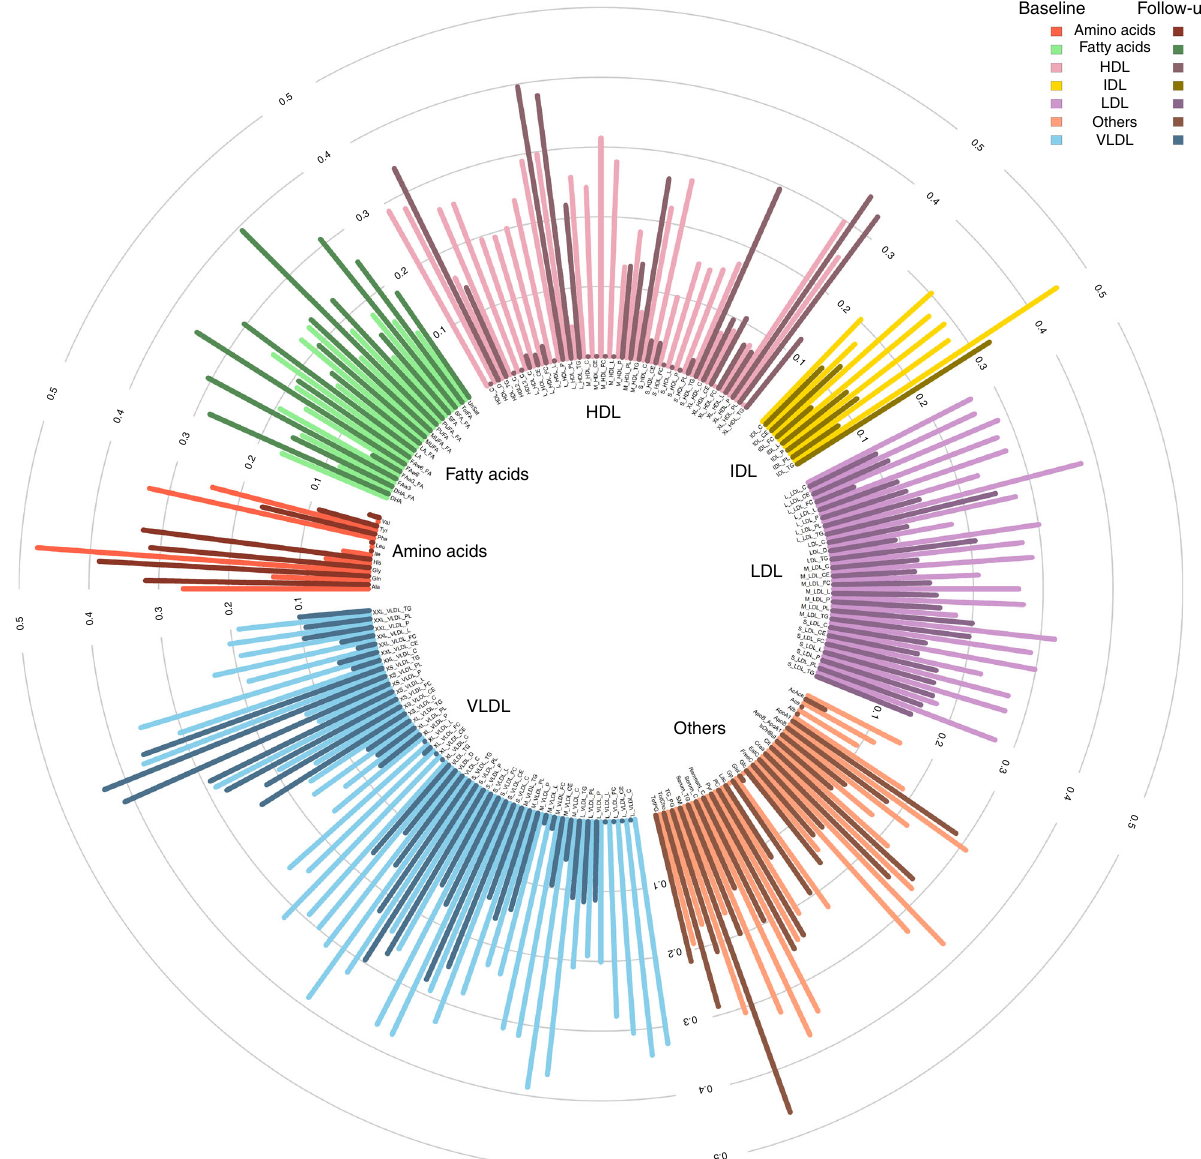
Fig. 7 Heritability of metabolites in baseline and follow-up data. Heritability of studied metabolites, computed on individuals present in both baseline and follow-up data. We used bivariate restricted maximum likelihood (REML) and included 10 genetic PCs, age, and age² as fi xed effects. Light colors stand for heritability in baseline data and dark colors stand for follow-up